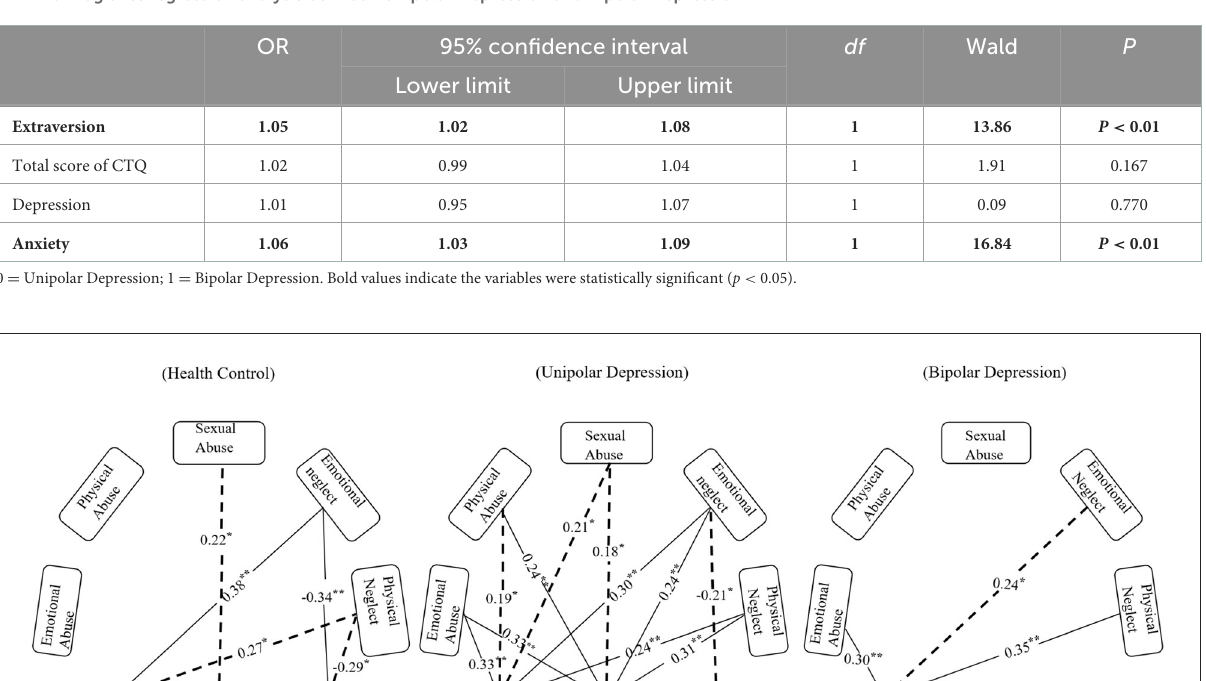
TABLE 3 Logistics regression analysis between Unipolar Depression and Bipolar Depression.